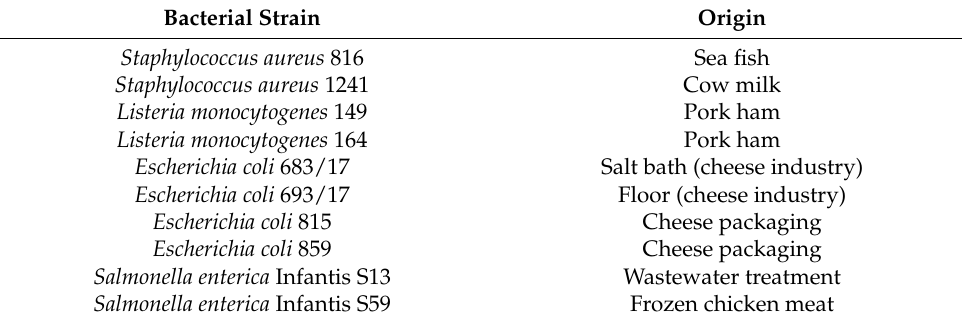
Table 8. List of bacterial strains and their